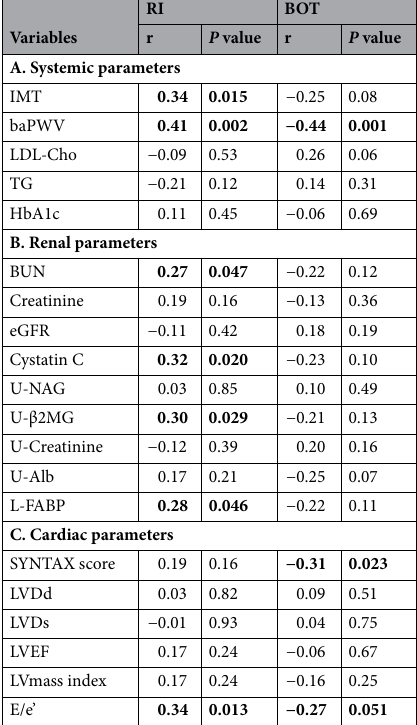
Table 2. Relationship between the ocular RI and BOT and systemic atherosclerosis parameters. LVmass index, left ventricular mass index. Other abbreviations are shown in Table 1. Significant values are in